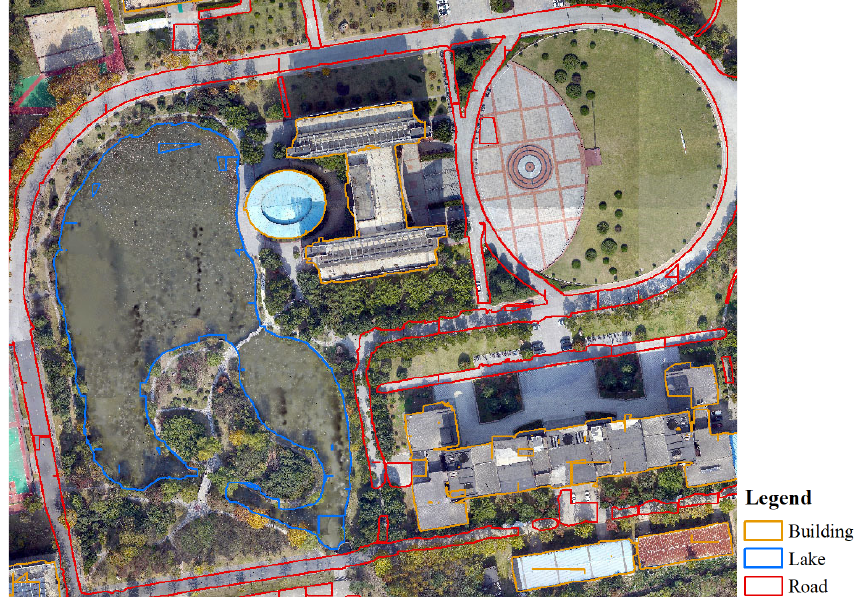
Figure 2. Split local